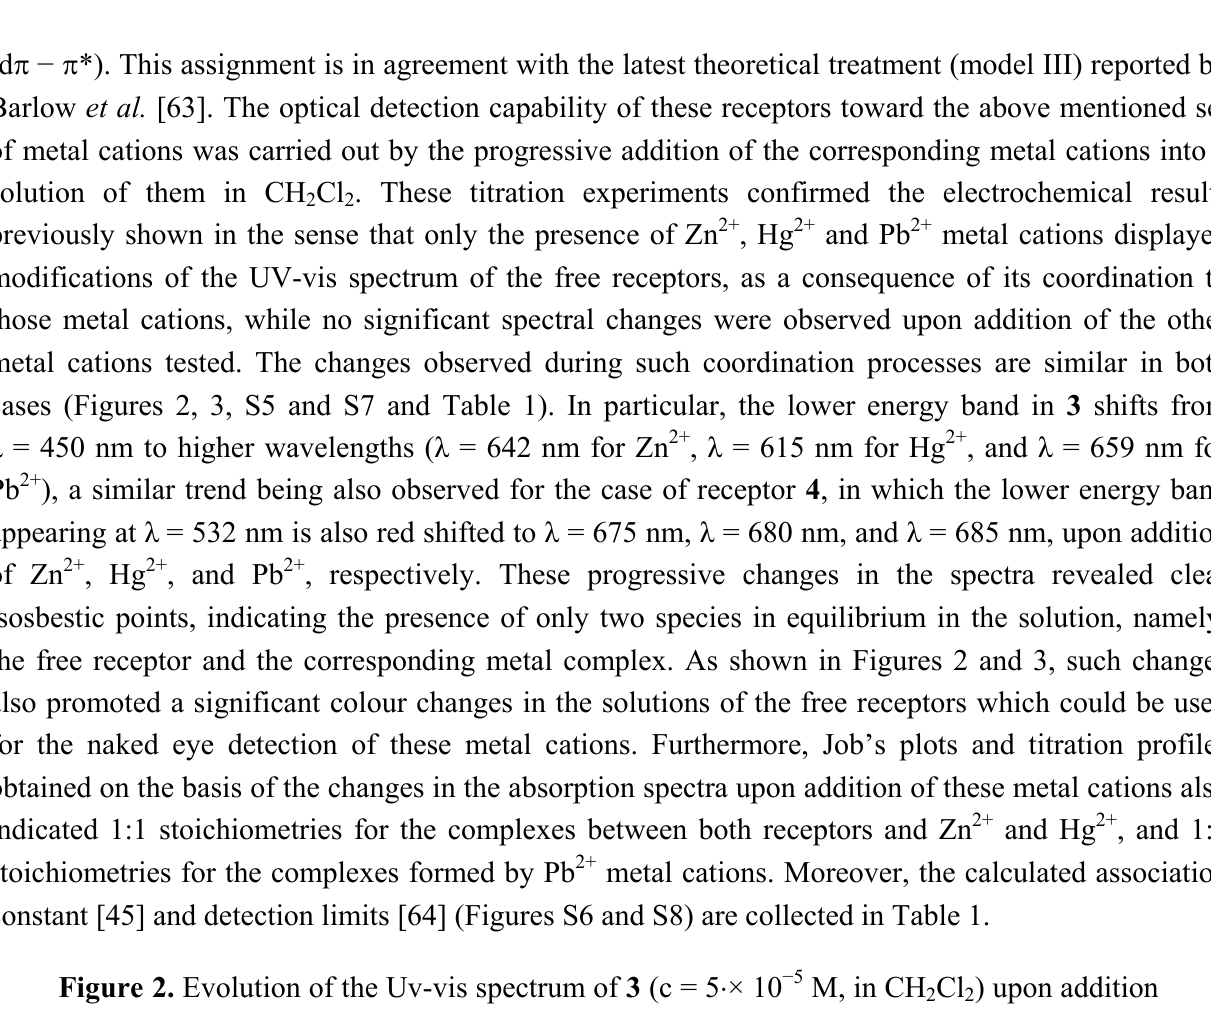
Cl ) upon addition 2 2 CN) until 2 equiv. 3